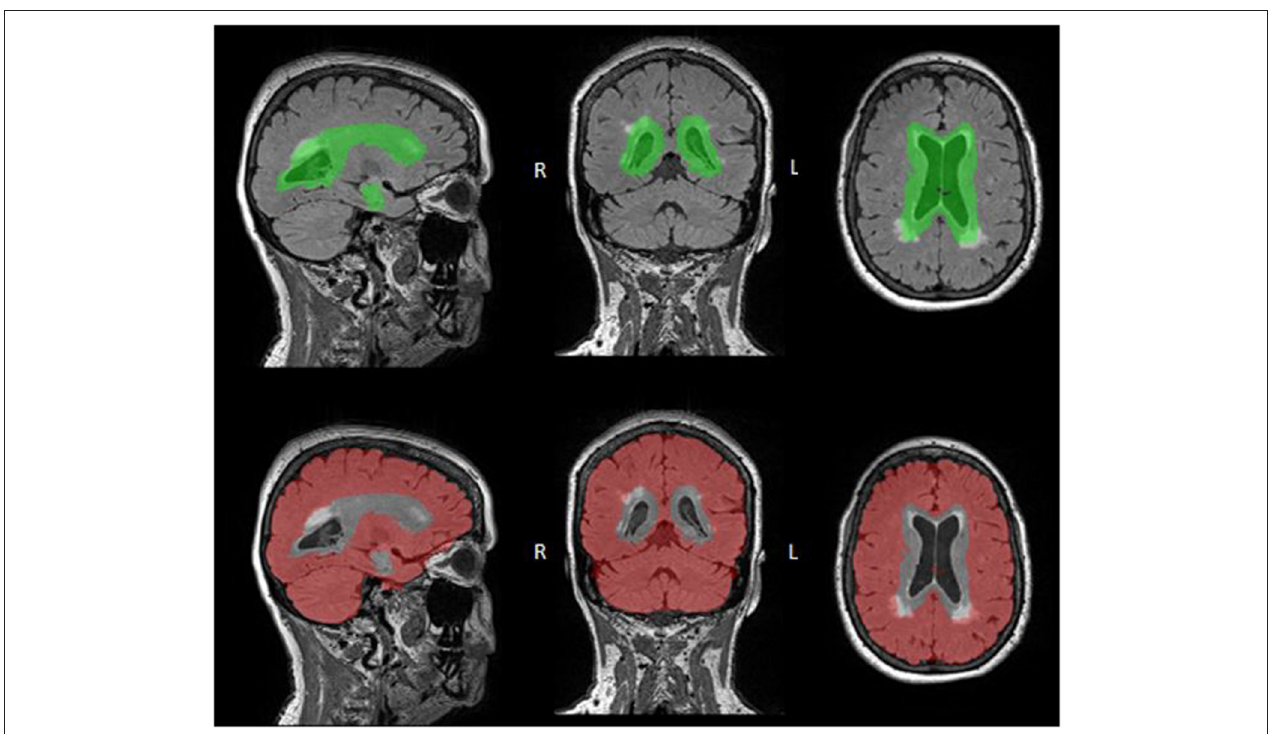
FIGURE 1 | WMH Regional ROI Masks. PV (top: green) and deep (bottom: red) ROI masks are overlaid onto FLAIR images. These ROIs were defined by registering the ALVIN mask to each participant’s native FLAIR space, with the area within the ALVIN mask defined as the PV ROI and the area outside defined as the deep ROI. Although both ROIs include all tissues, not just WMHs, these ROIs were multiplied by the participants WMH mask resulting in only WMH volume in each